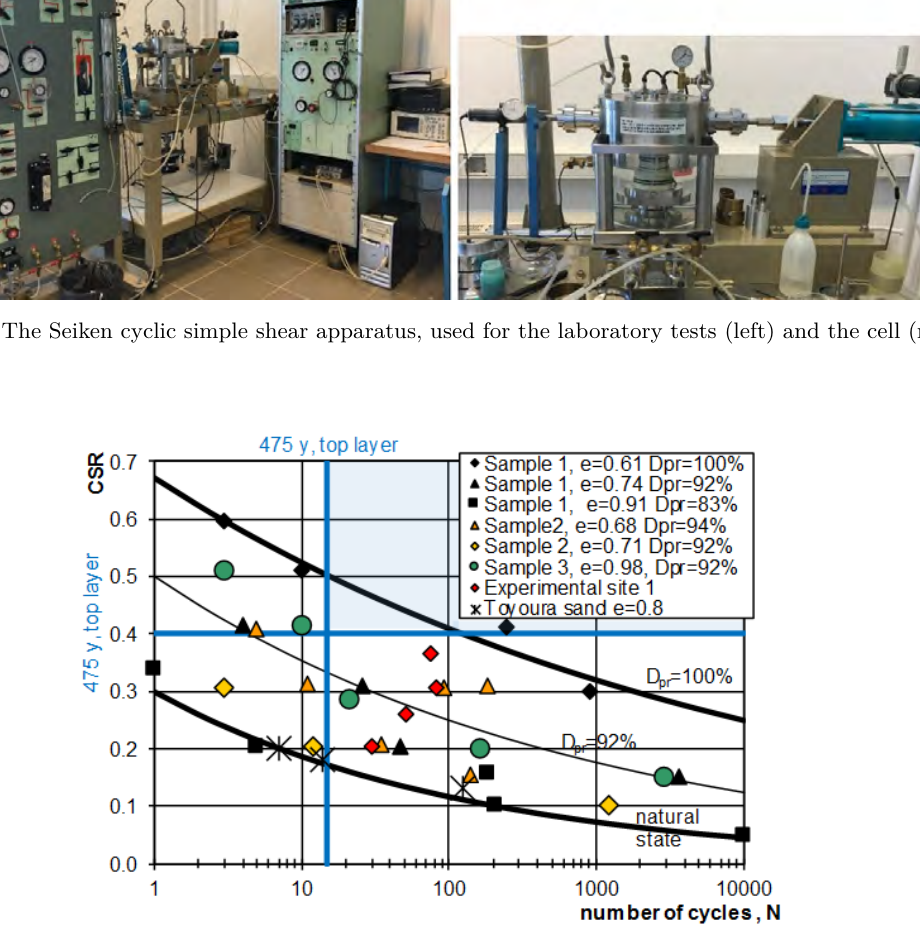
Figure 7. The relationship between the number of cycles needed for liquefaction and the cyclic stress ratio (CSR) for top soils at different void